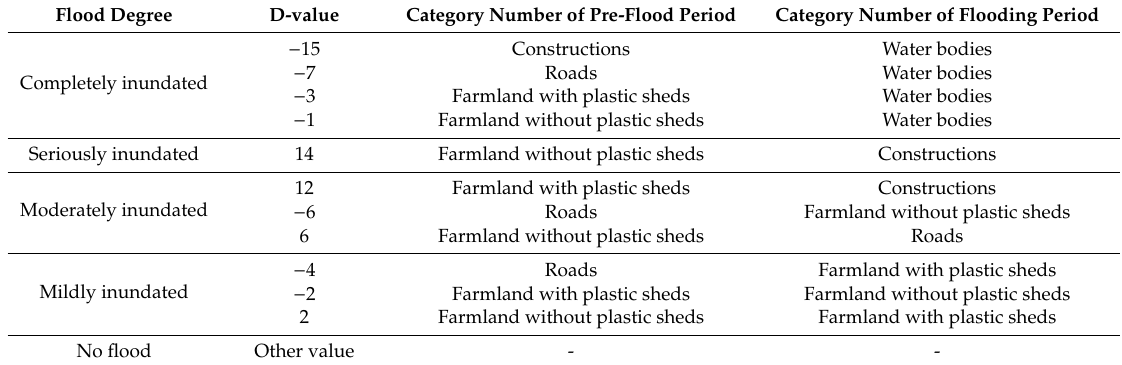
Table 5. Flood degrees and their evaluation